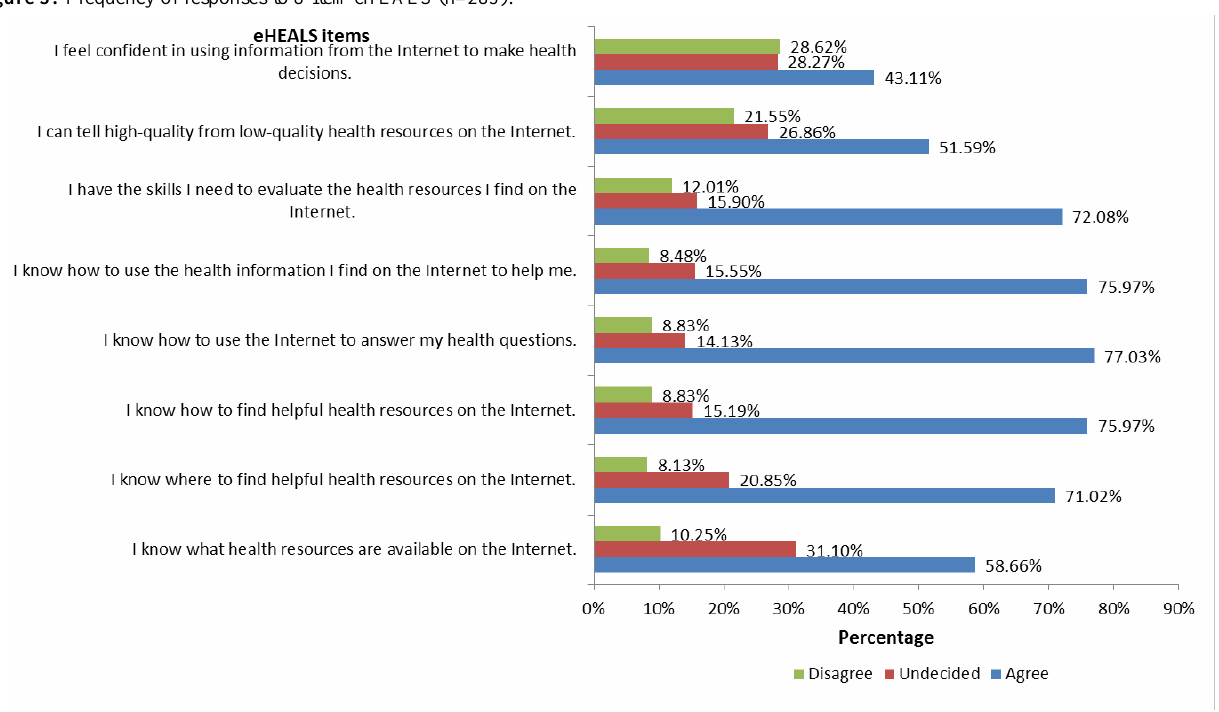
Figure 3. Frequency of responses to 8-item eHEALS